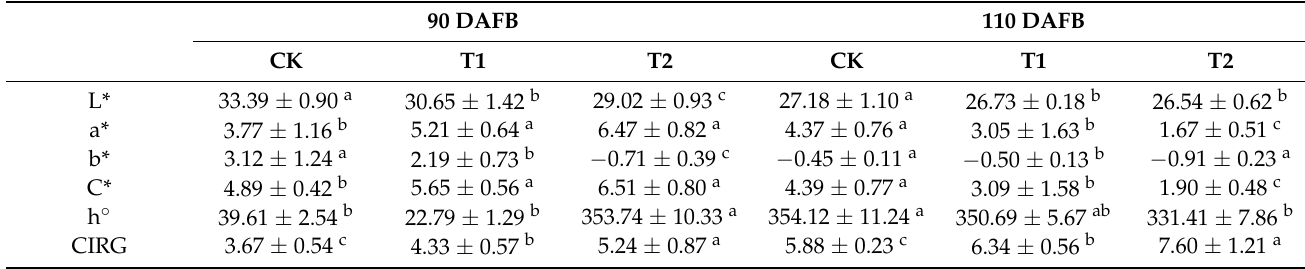
Table 2. The chromaticity values of the ‘Kyoho’ grape berries under different potassium fertilizer